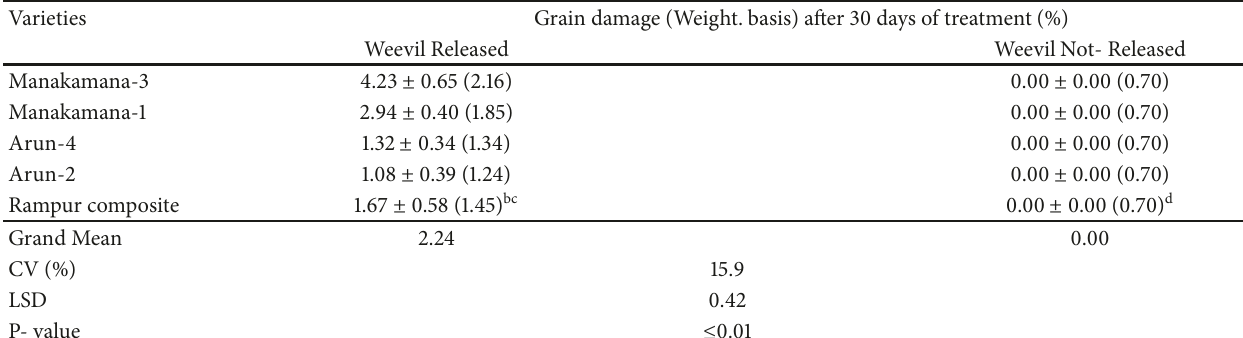
Table 3: Damage of maize weevil, Sitophilus zeamais Motsch on maize varieties infestation with fungus under no choice condition at NAST, Lalitpur, Nepal, 2016. Varieties Grain damage (Weight. basis) after 30 days of treatment